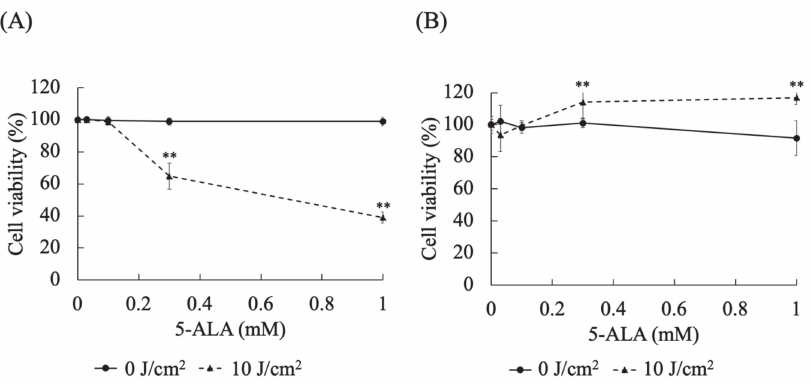
Figure 3. Evaluation of the cytotoxic effects of different 5-ALA doses on canine primary lung adenocarcinoma cell lines. ( A ): HDC cells. ( B ): LuBi cells. HDC and LuBi cells were seeded at 1–2 × 10 4 cells per well into 96-well plates. Following 24 h of incubation, the HDC and LuBi cells were incubated with different concentrations of 5-ALA (0, 0.03, 0.1, 0.3, and 1 mM) for 4 h. After changing the medium, the cells were irradiated with an LED light source light (630 nm, 20 mW/cm 2 , 10 J/cm 2 ). Results are presented as mean ± standard deviation ( n = 6). Groups were compared using Sidak’s multiple comparison test, ** p < 0.01.